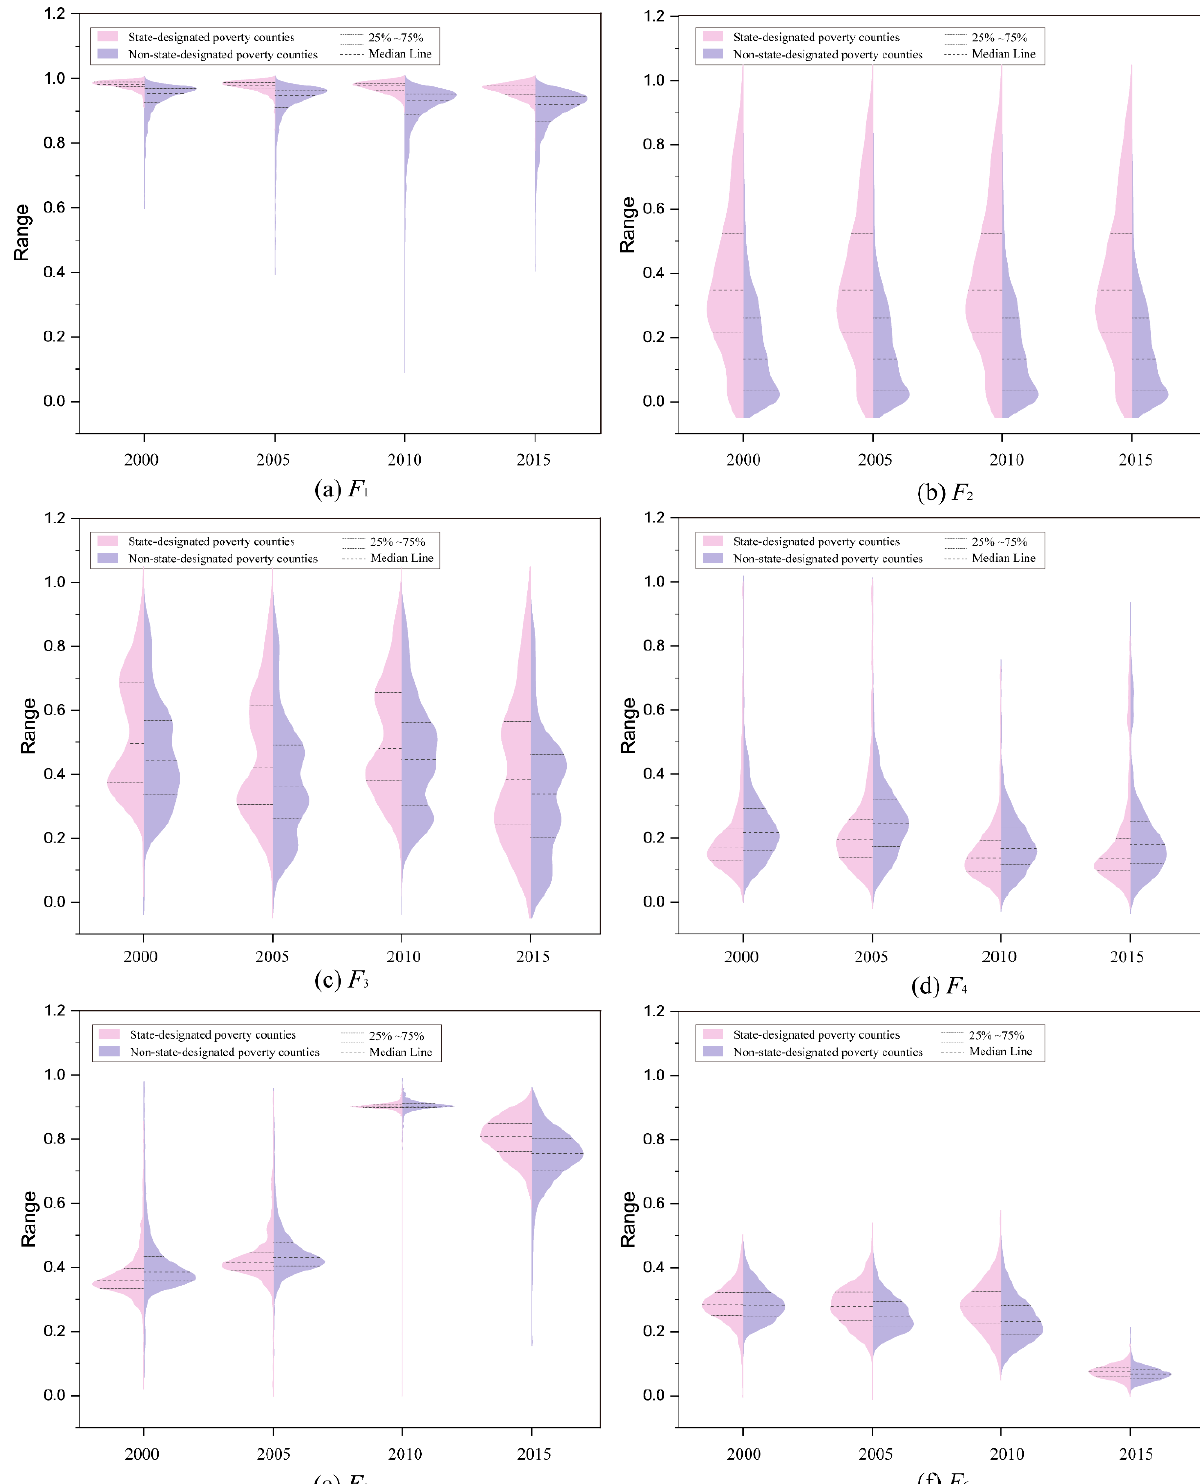
Figure 6. Violin plot of six PDFs in state-designated poverty counties and non-state-designated poverty counties: ( a ) F 1 : Economic capital deprivation; ( b ) F 2 : Geographical capital deprivation; ( c ) F 3 : Natural resource endowment capital deprivation; ( d ) F 4 : Agricultural capital deprivation; ( e ) F 5 : Human and labor capital deprivation; and ( f ) F 6 : Compulsory education deprivation. Lower values indicate better capital in that area and higher values indicate poorer capital.